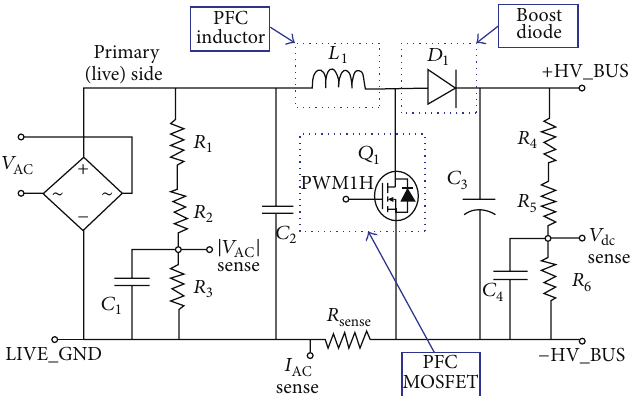
Figure 2: Architectural design of the IPFC